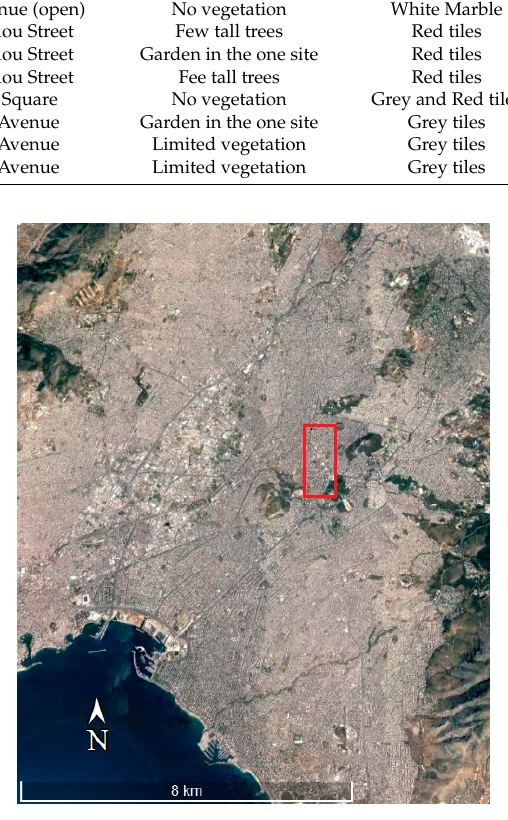
Figure 1. Survey area in GOOGLE EARTH.